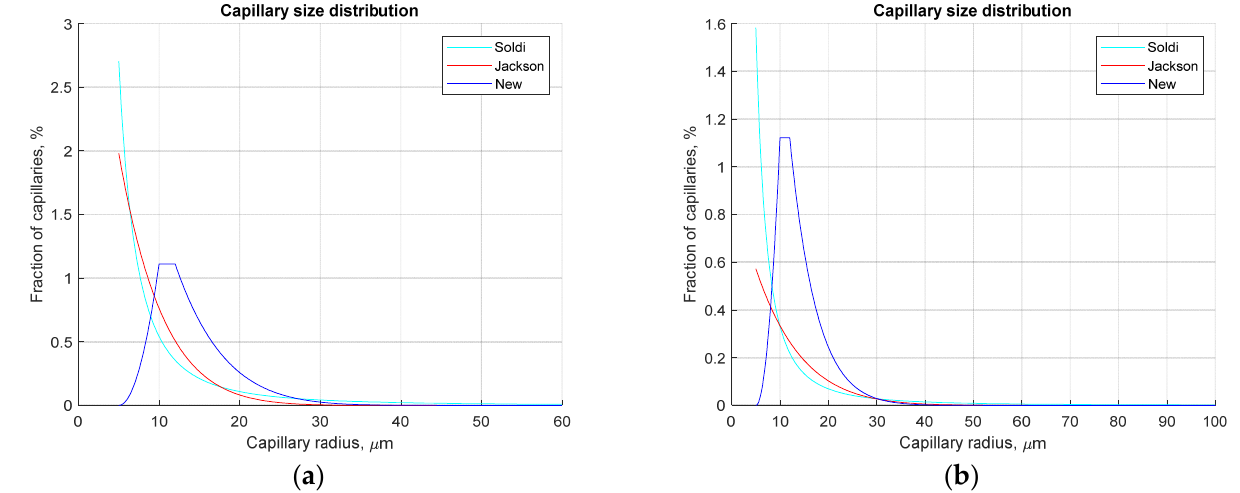
Figure 3. Frequency distribution comparison of Soldi , Jackson and New CSD functions using straight capillaries with tortuosity of 4.5, dr c = 0.1 µ m, r min = 5 µ m and ( a ) r max = 60 µ m and ( b ) r max = 100 µ